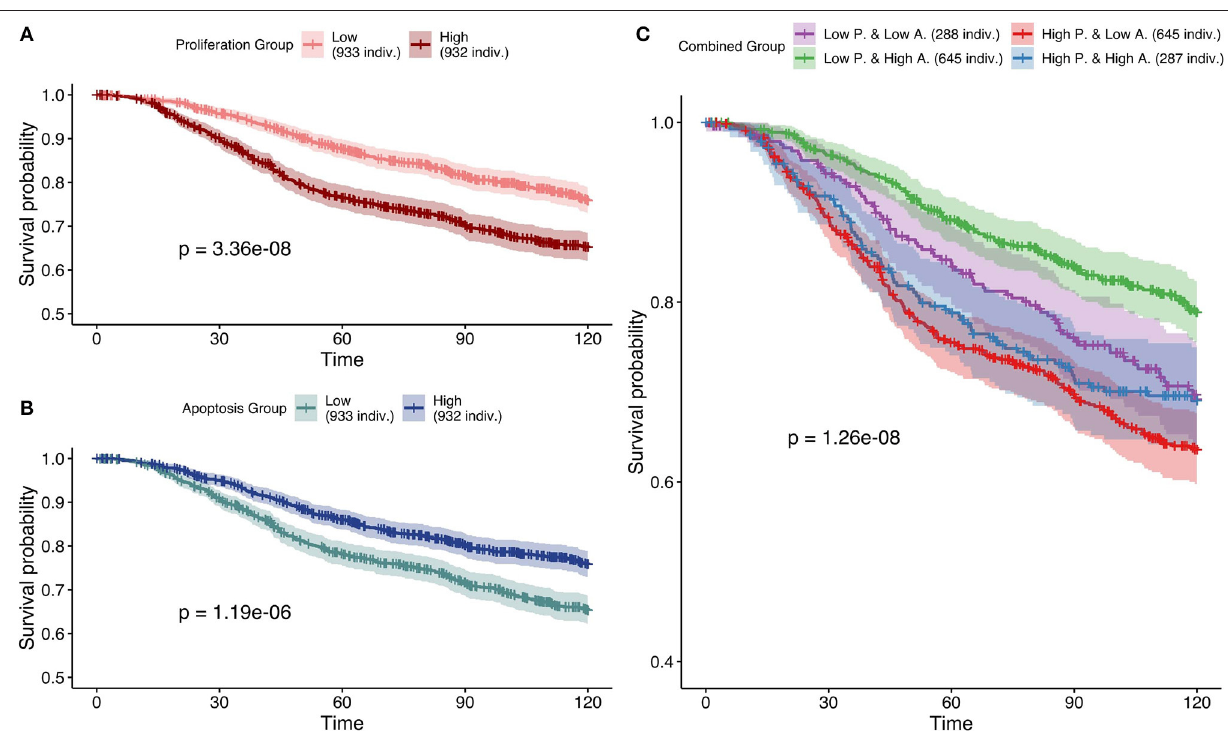
FIGURE 10 | Survival analyses of METABRIC samples from which exome mutations are used as Strict Node Variants and RNA as Soft Node Variants in the model (case 5). All p -values are derived from a log-rank test. (A) Survival curves with high and low Proliferation groups. (B) Survival curves with high and low Apoptosis groups. (C) Survival curves with combined